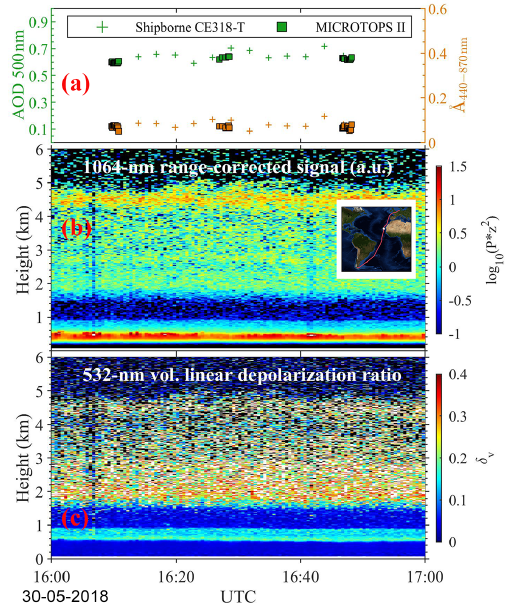
Figure 13. Aerosol observation with the shipborne CE318-T, MI- CROTOPS II and Polly XT lidar with strong dust loading on 30 May 2018. (a) Comparison of 500nm AOD and Ångström ex- ponent at 440–870nm with shipborne CE318-T and MICROTOPS II, (b) the dust layer extending from 1.5 to 5km and MBL reaching 0.6km, as indicated by the strong range-corrected signal at 1064nm (red), and (c) volume depolarization ratios indicating the marine layer (low values, blue) and the Saharan dust layer (high values, green and